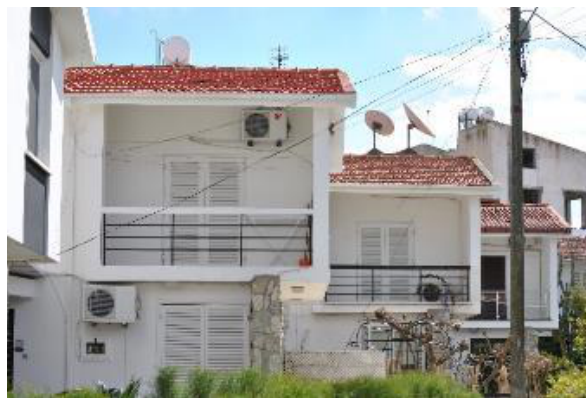
Figure 23. South Elevation Efrus House (Image by Author, 2016).